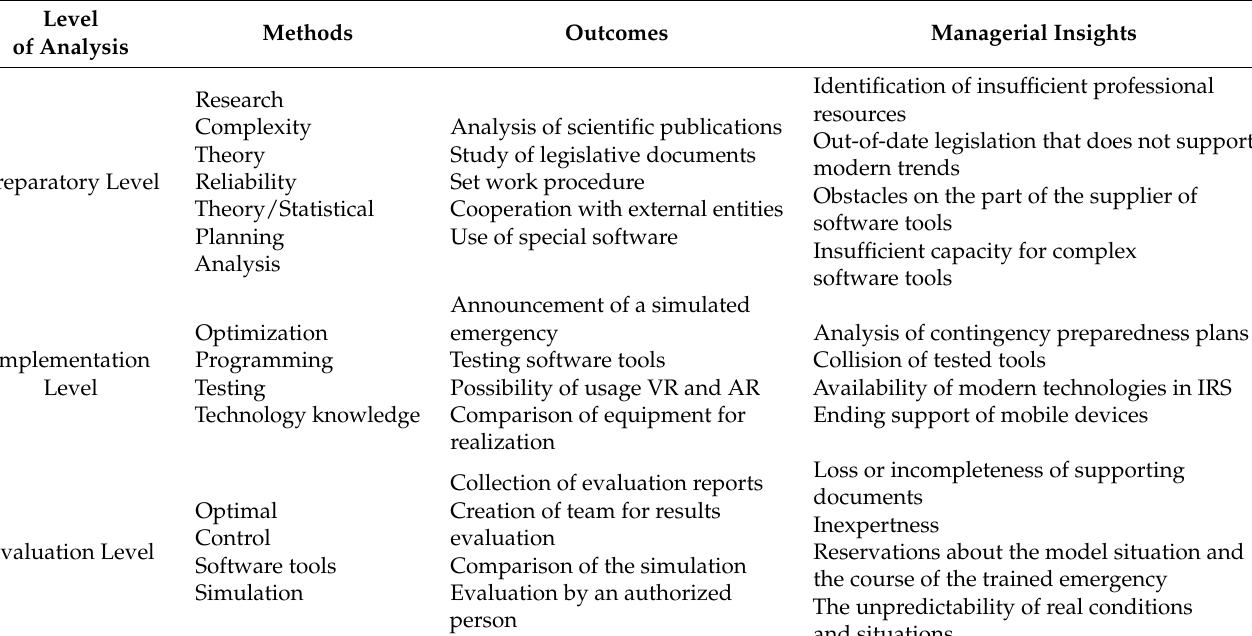
Table 4. Outcomes and managerial insights for Integrated Rescue System software